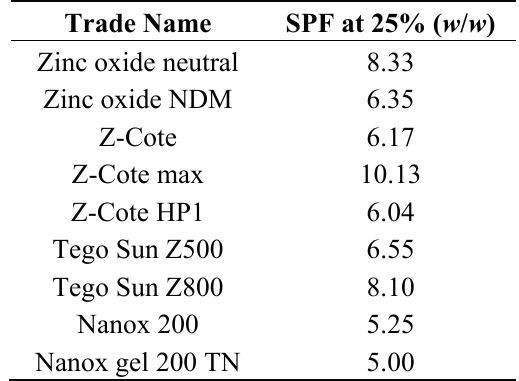
Table 6. Efficacy of different commercial forms of zinc oxide compared in terms of photoprotection